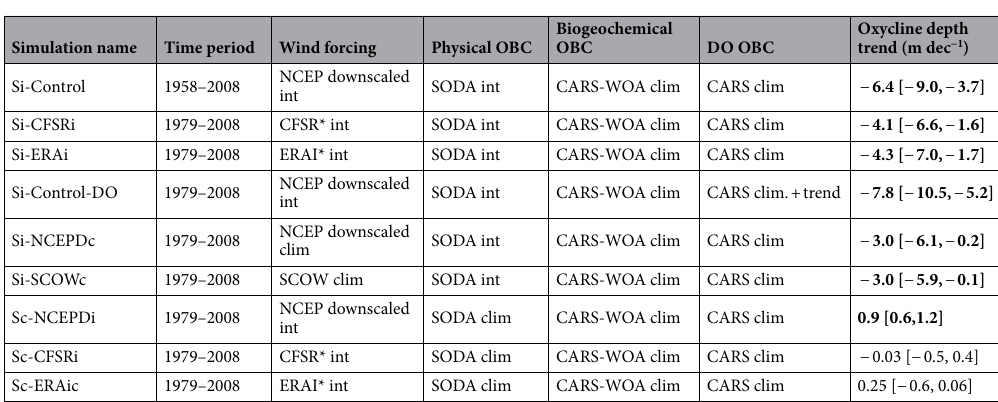
Table 1. Numerical simulations design. Characteristics of the numerical simulations (simulation name, time period, wind forcing, physical open boundary conditions (OBC), biogeochemical OBC, DO OBC and oxycline trend). Asterisks in the wind forcing column indicate that the forcing is composed of a SCOW monthly climatology and atmospheric model monthly anomalies. “int” means interannual and “clim” means climatological. Oxycline trends are indicated in bold font when statistically significant, along with the corresponding confidence